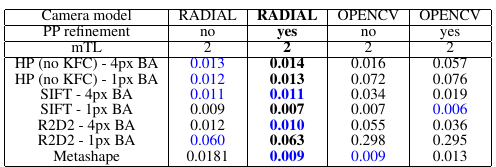
Table 4. RMSEs [m] for different camera setups of the Paestum Wall Full dataset.